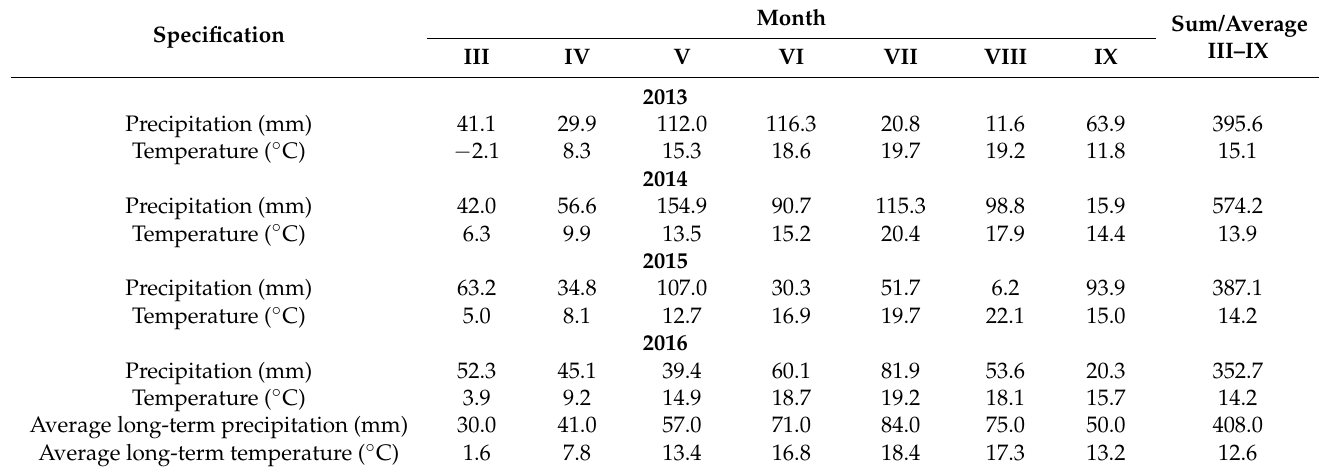
Table 2. Weather condition data for the growing seasons of the